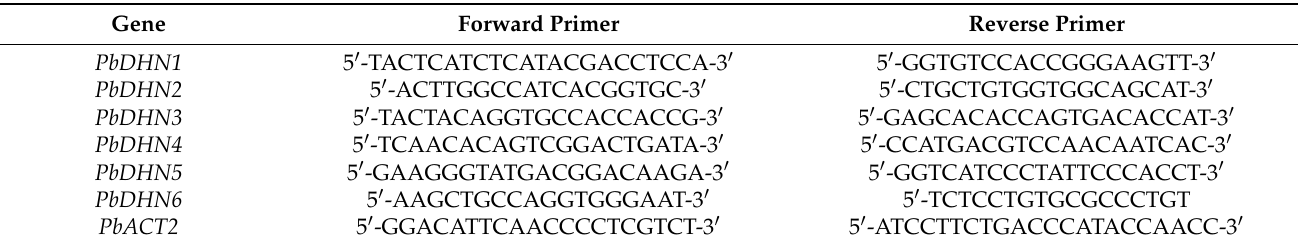
Table 2. Primers of PbDHN s for